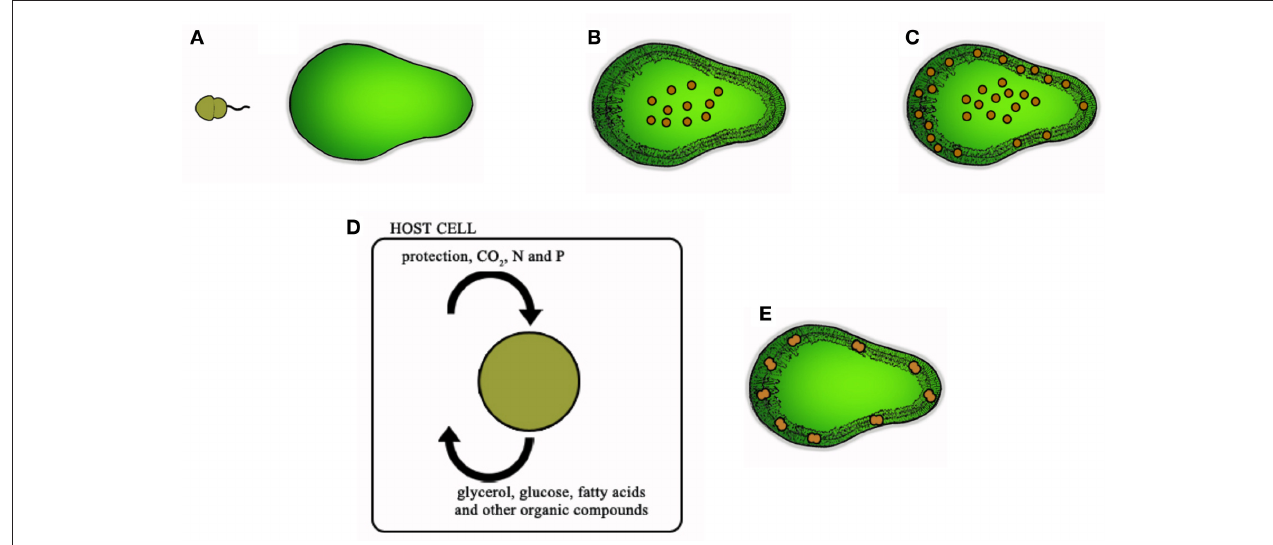
FIGURE 3 | Steps for the establishment of a mutualistic relationship between Symbiodinium and metazoan larvae, using a coral planula as an example: (A) larval acquisition of free-living Symbiodinium zoospore, (B) symbiont inside gastrovascular cavity immediately after acquisition, (C) symbiont transfer to endodermal tissues, (D) metabolite/favor exchange, and (E) symbiont reproduction and long-term persistence.